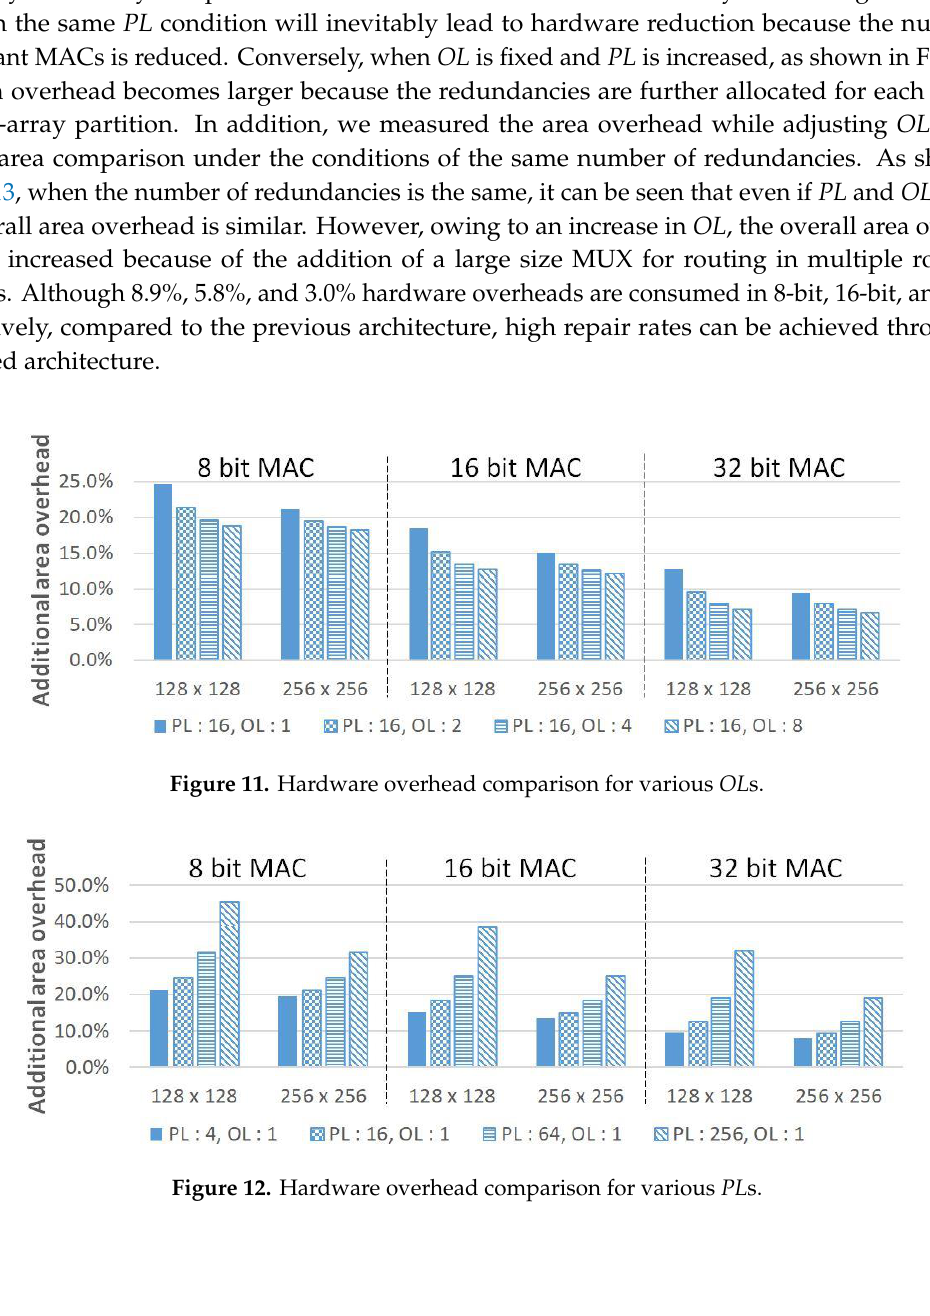
Figure 13. Hardware overhead comparison under the same number of redundancies condition. 5. Conclusion To ensure the reliability of the systolic-array architecture, which is widely used in neural- network computing, a new efficient redundancy architecture is proposed. The proposed architecture can repair a larger number of faults than the previous redundancy architecture, with reasonable hardware overhead. Moreover, unused redundant MACs are utilized in the online repair process through programmable fuses. For maximizing the efficiency of the online repair process, group-based repair strategy is adopted in the entire repair process. This provides maximum redundancies utilization by minimizing hardware overhead waste. Author Contributions: Conceptualization, K.C. and I.L.; methodology, K.C. and I.L.; software, K.C. and I.L.; validation, K.C., I.L., and H.L.; formal analysis, I.L.; investigation, K.C. and H.L.; resources, K.C.; data curation, K.C.; writing — original draft preparation, K.C. and I.L.; writing — review and editing, K.C. and S.K.; visualization, K.C. and I.L.; supervision, S.K.; project administration, S.K.; funding acquisition, S.K. All authors have read and agreed to the published version of the manuscript. Funding: This work was supported by Samsung Electronics Company, Ltd., Hwaseong, Korea. Conflicts of Interest: The authors declare no conflict of interest. References 1.